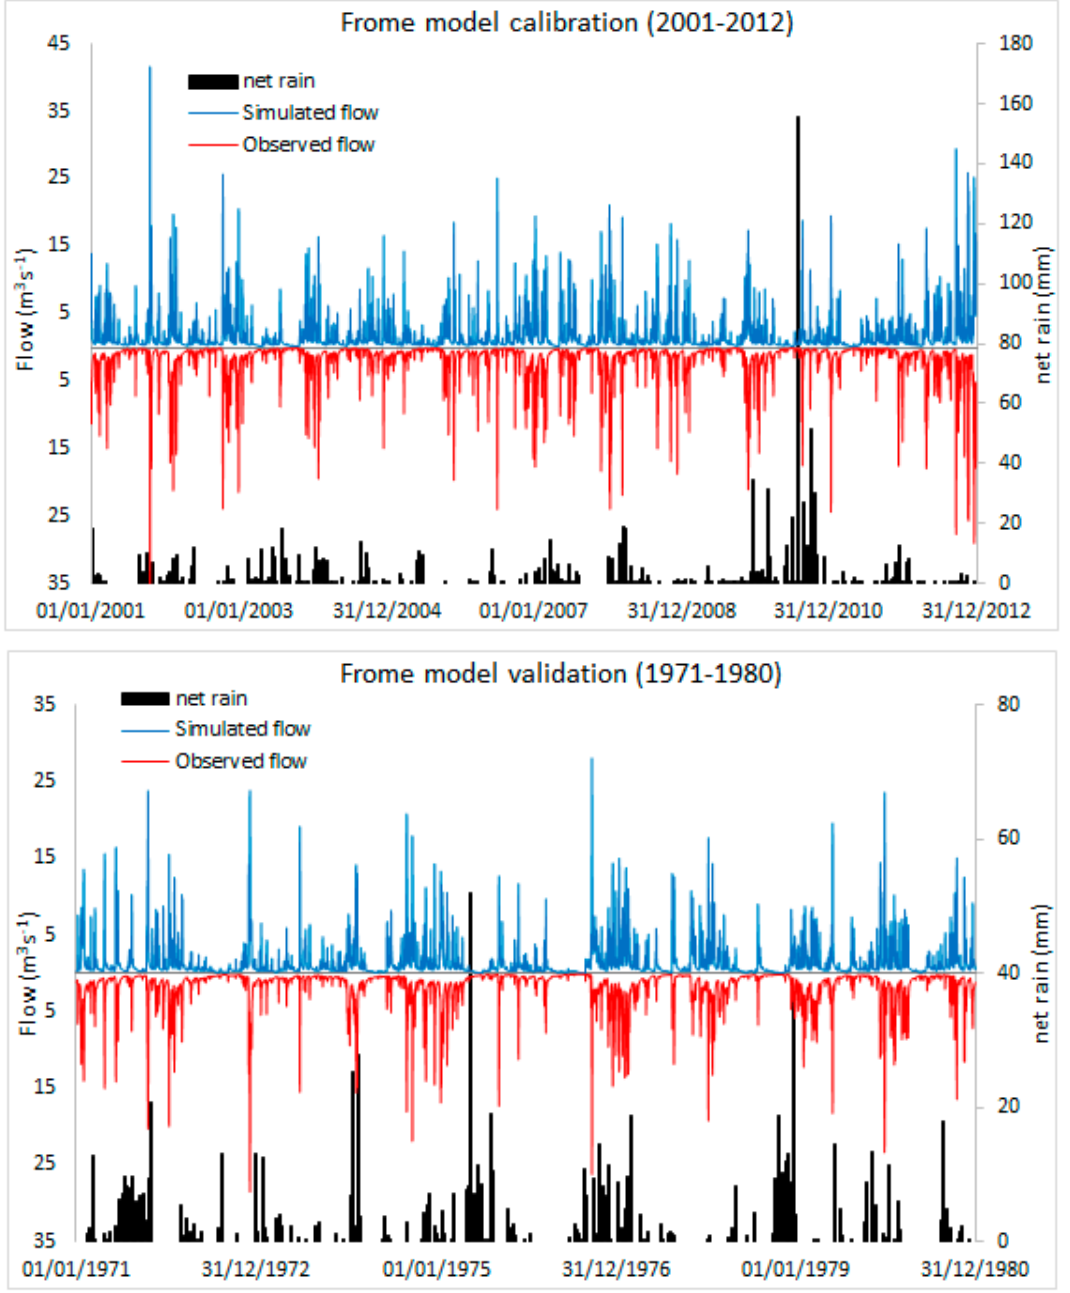
Figure 5. Model calibration of streamflow during the 2001–2012 and validation for the period 1971–1980.